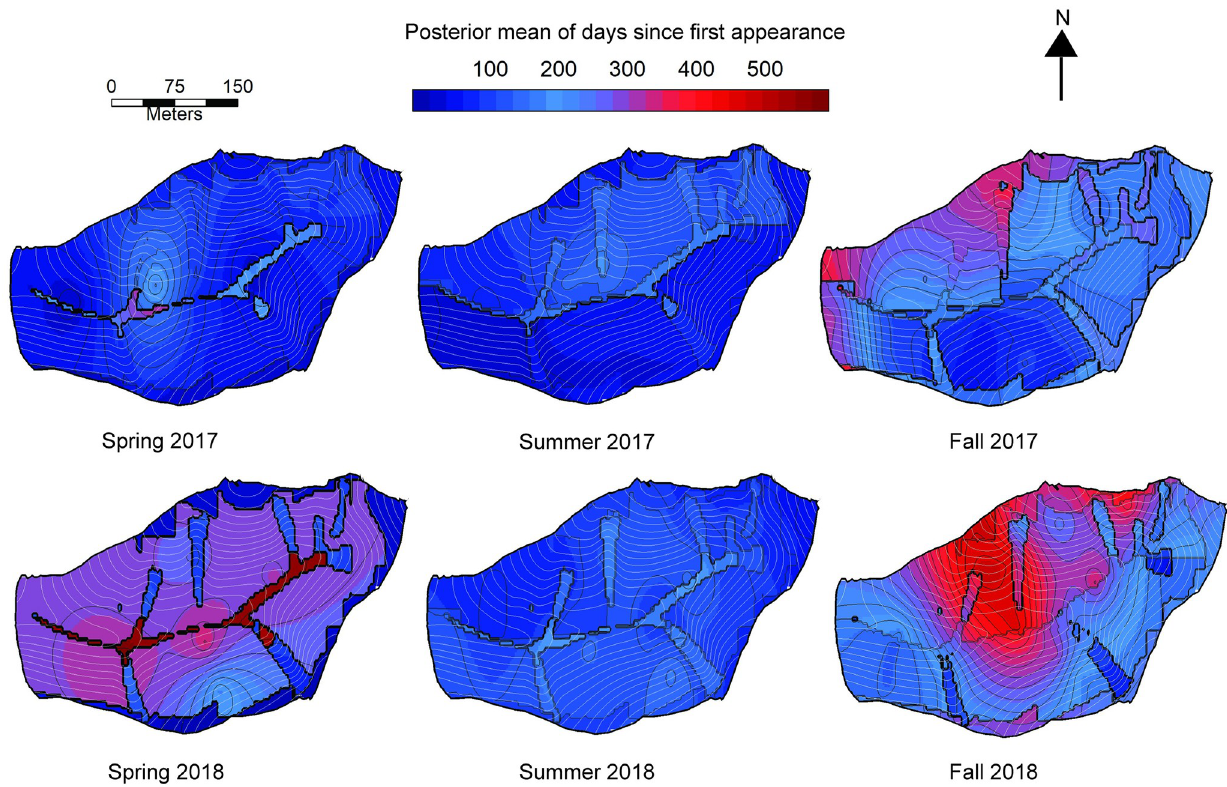
Fig 5. Seasonal trends in first-order root lifespan across the Susquehanna Shale Hills Critical Zone Observatory. Bayesian regression models were used in kriging. Maps displayed are posterior means of days since first appearance of a root in the upper 10 cm of soil. Number of plots with at least ten roots produced ( n � 10) that were used in kriging were as follows: Spring 2017 (13 plots), summer 2017 (35), fall 2017 (25), spring 2018 (9), summer 2018 (38), and fall 2018